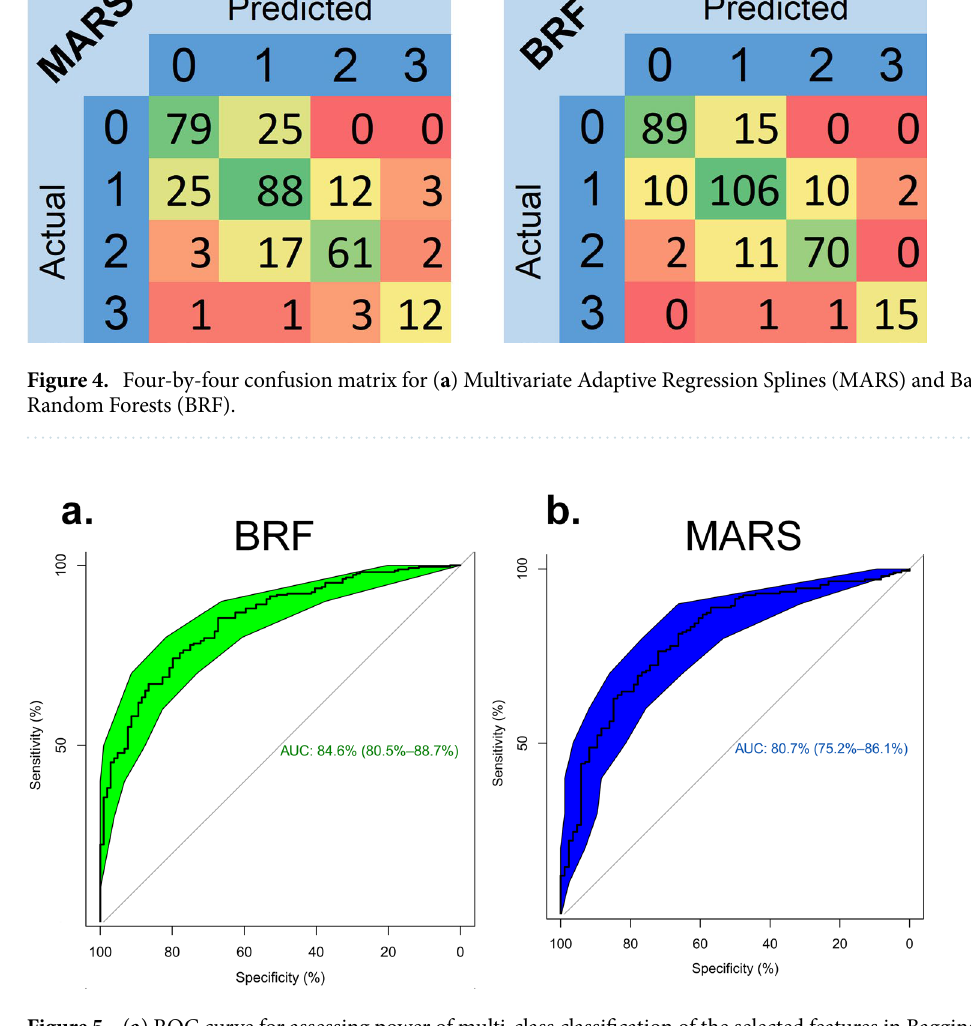
Figure 5. ( a ) ROC curve for assessing power of multi-class classification of the selected features in Bagging Random Forests (AUC = 0.846), and ( b ) Multivariate Adaptive Regression Splines (AUC = 0.807). Statistical comparison of ROC curves by “pROC” R package indicated significant difference (Z = 3.834, p value <